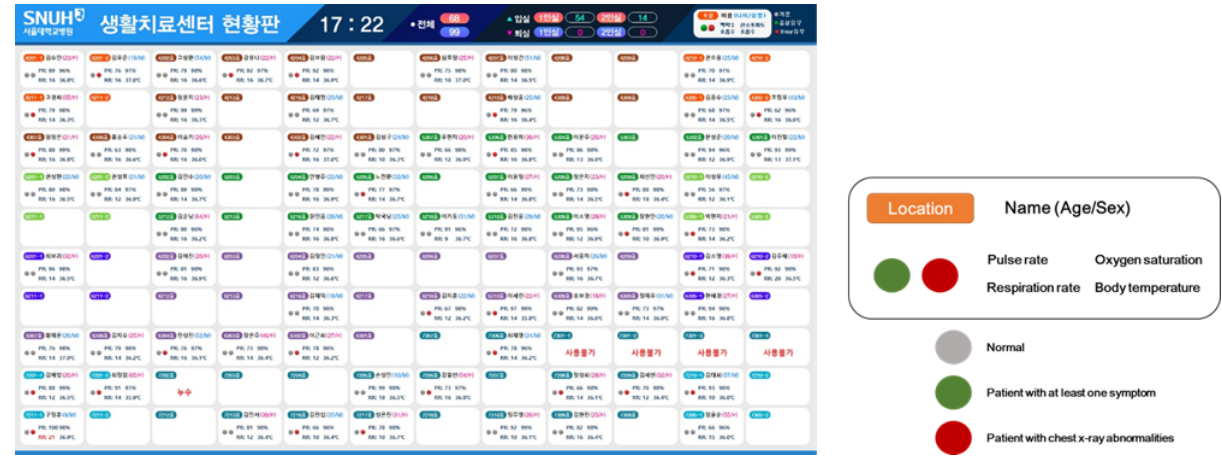
Figure 3. Dashboard of the EHR displaying real time information for patients at the LTSC.